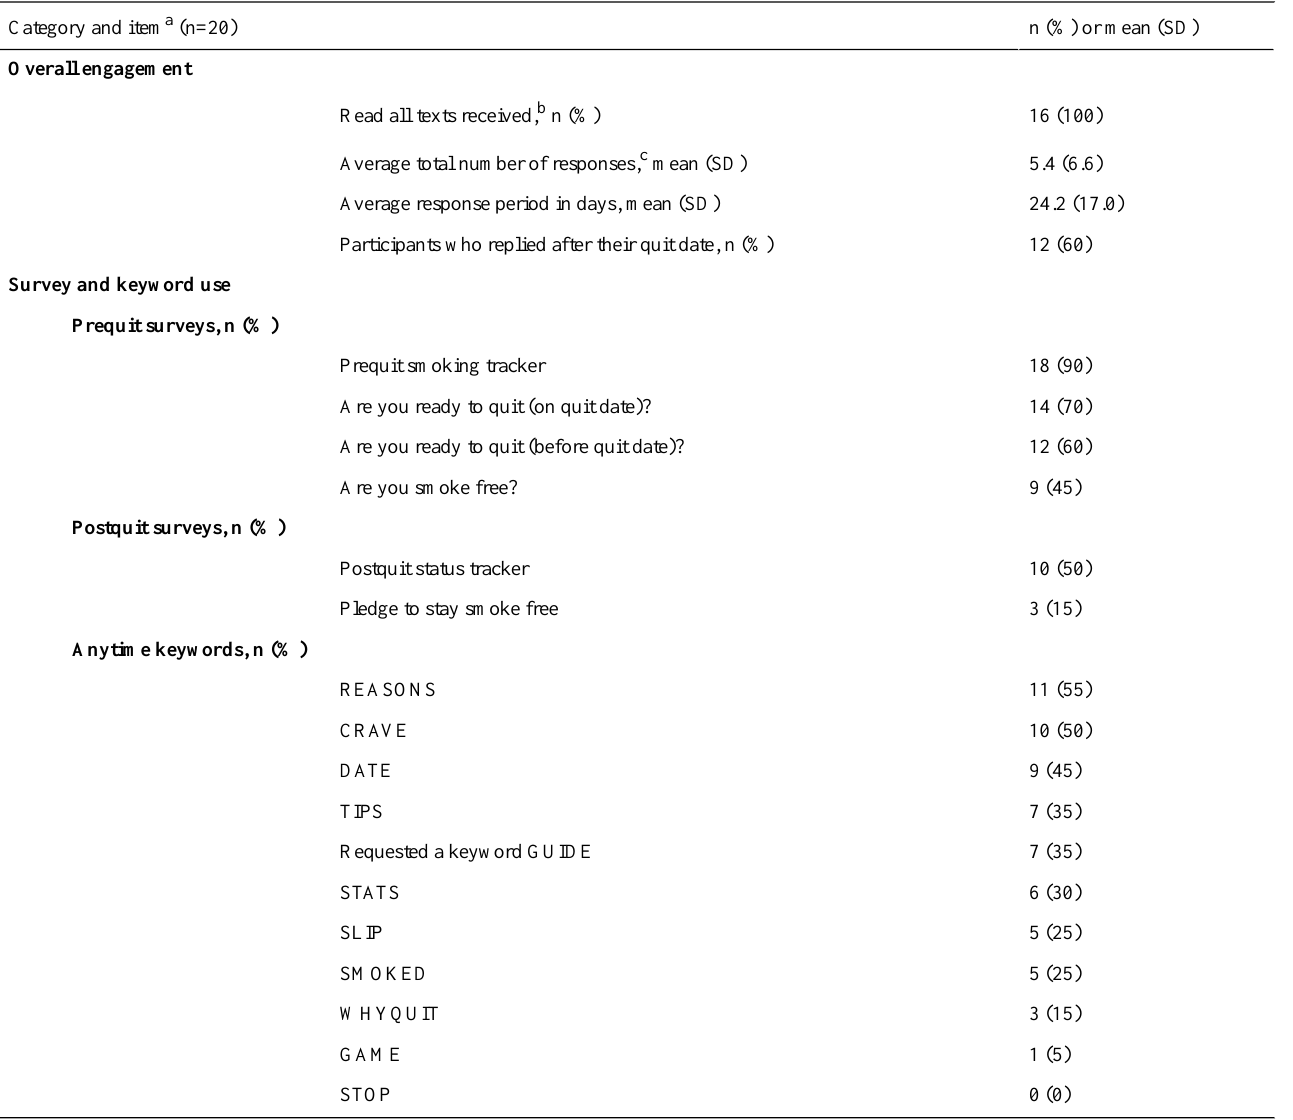
Table 3. Program engagement and characteristics of responses to text messages.